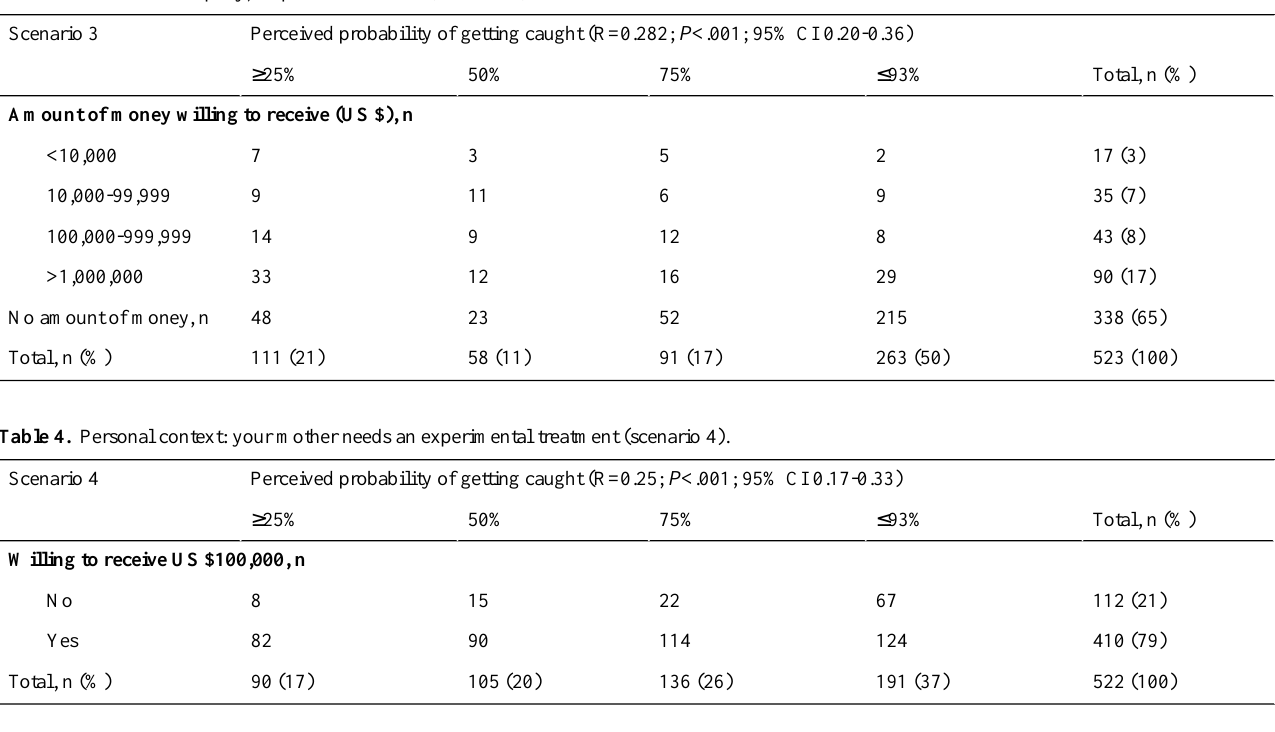
Table 3. Insurance company, no personal context (scenario 3).